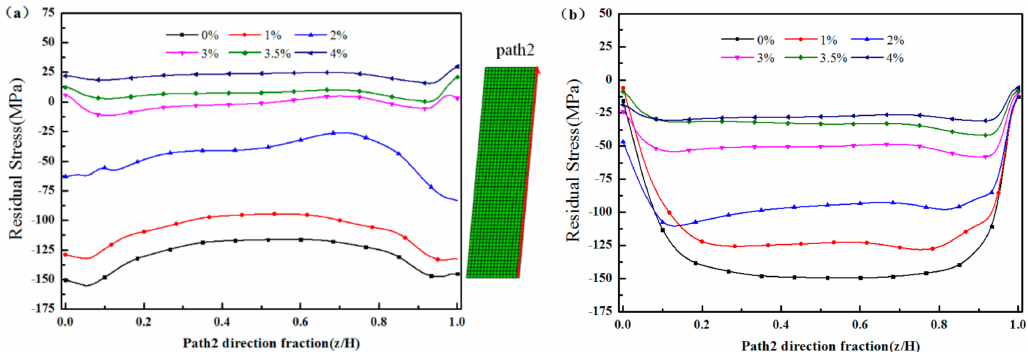
Figure 11. Residual stresses of the quenched tapered cylinder forgings along path 2 under different cold bulging ratio conditions: ( a ) σ t and ( b ) σ z